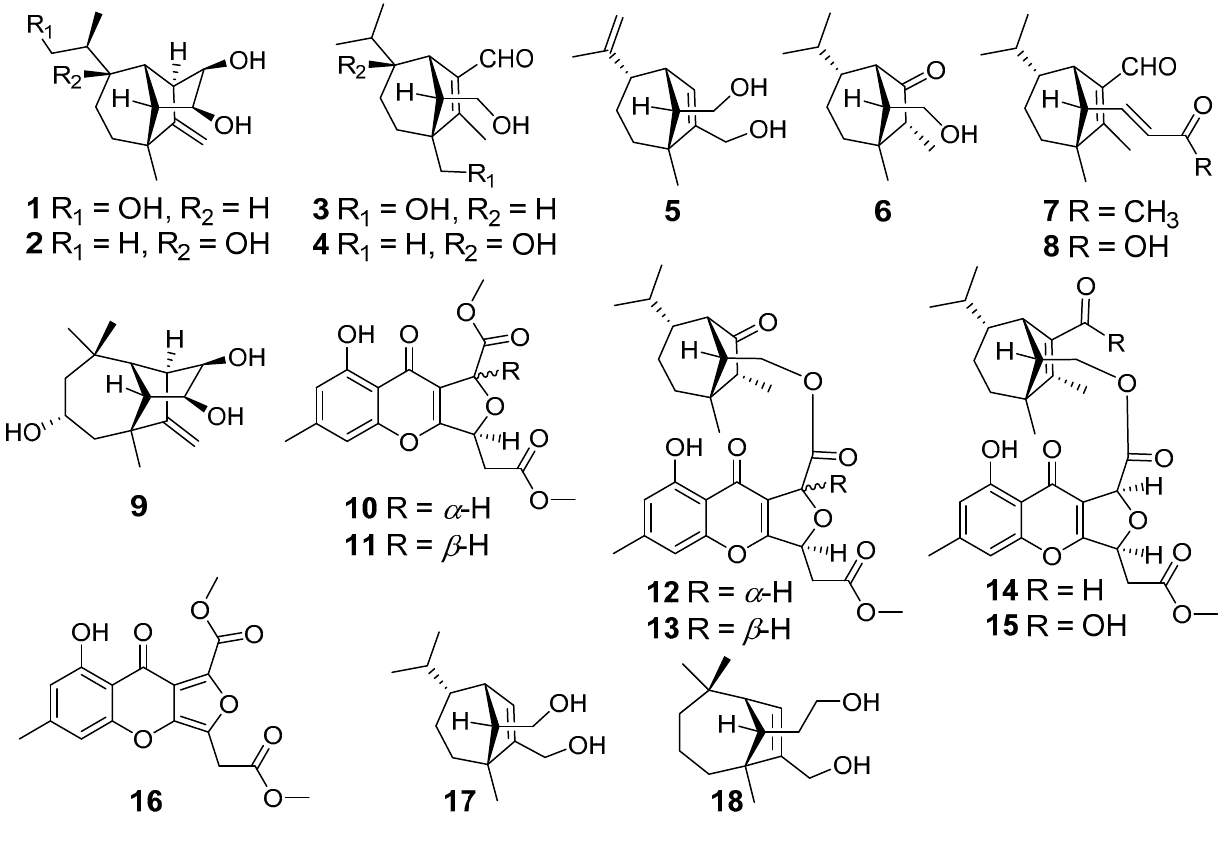
Figure 1. Structures of compounds 1 – 18 .